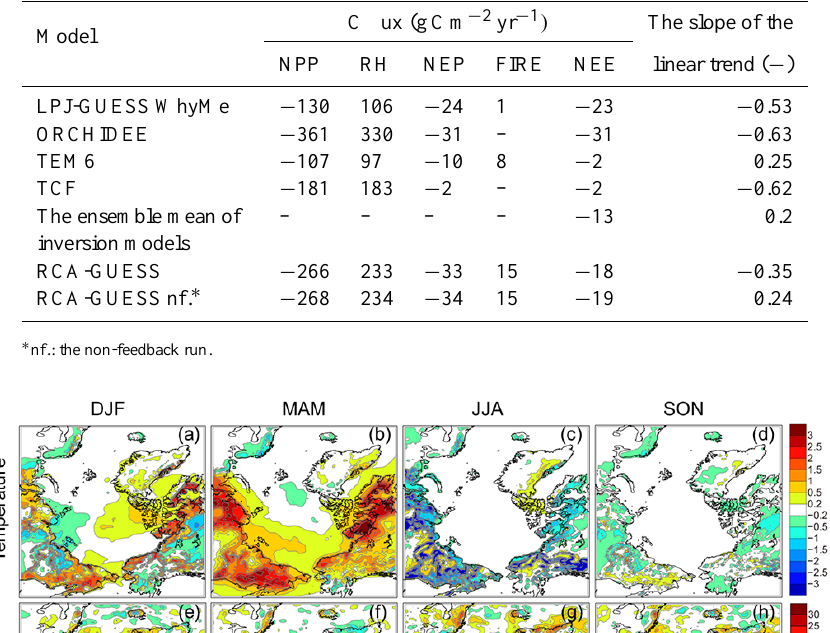
Table 1. Mean carbon budget of Arctic tundra simulated by process-based models, inversion models and RCA-GUESS for the period 1990– 2006.